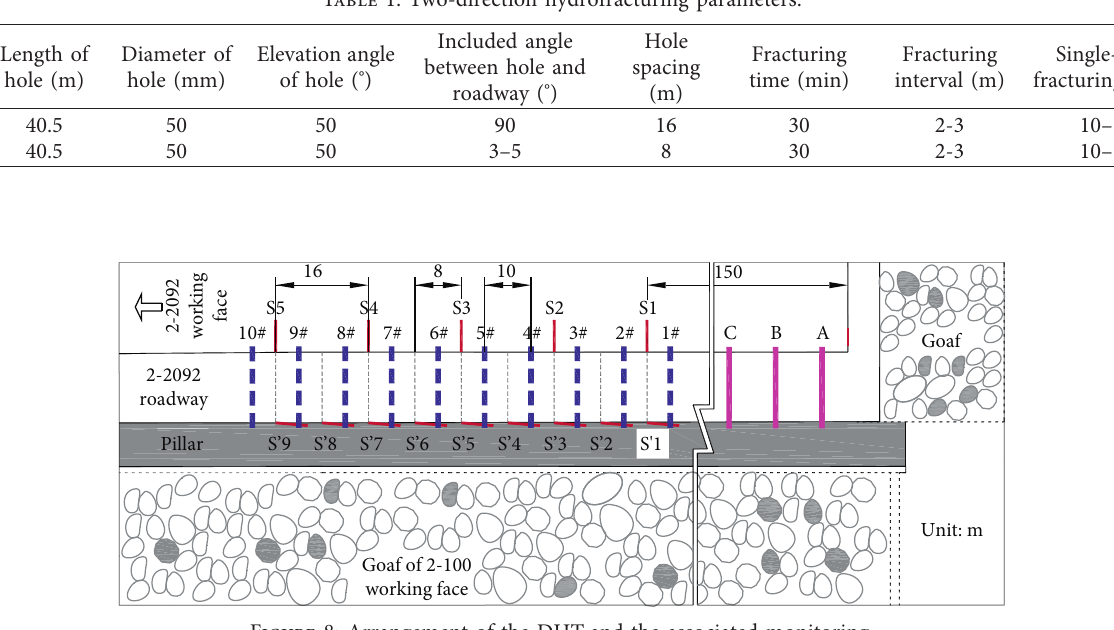
Figure 7: Influencing scope of superposed stress. Table 1: Two-direction hydrofracturing parameters.